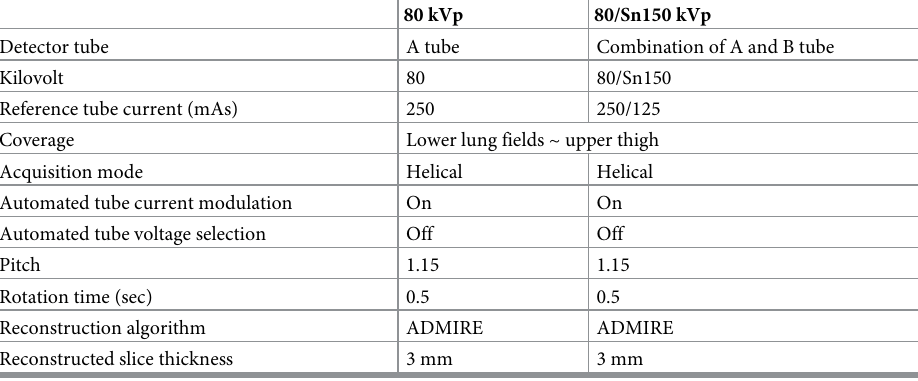
Table 1. CT acquisition scanning